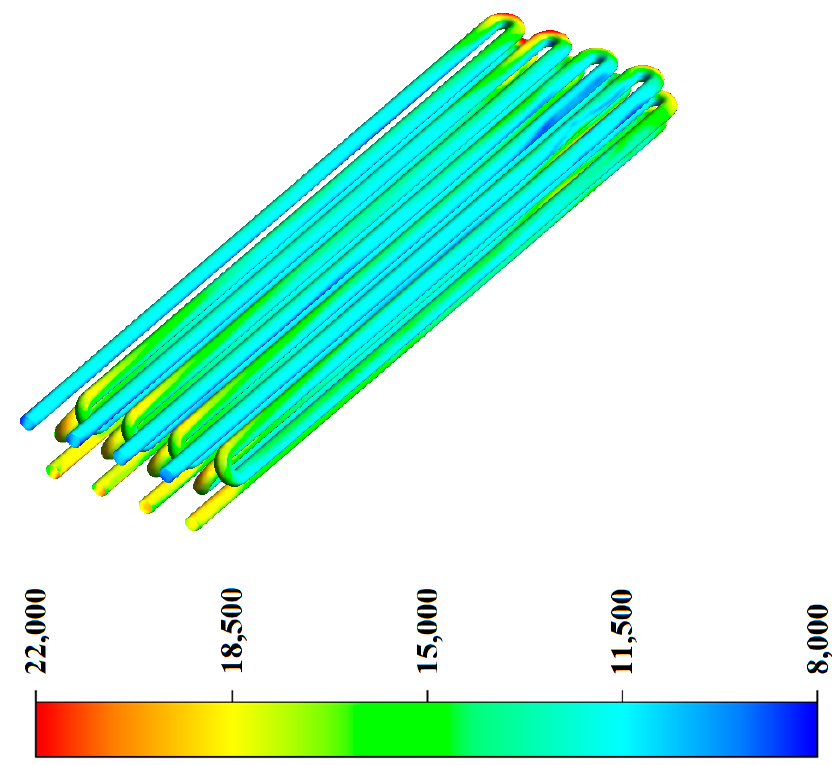
Figure 11. A 3D representation of the distribution of heat flux across the coil wall.